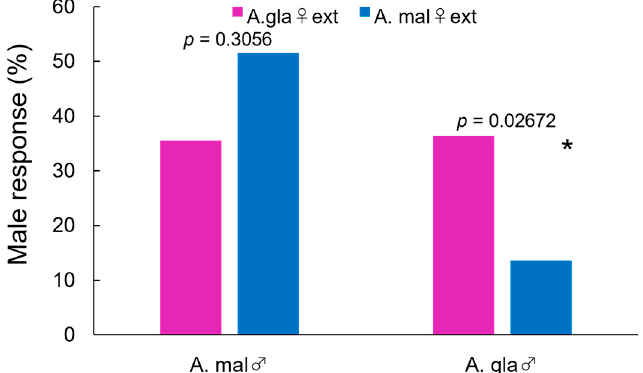
Figure 2. Male abdominal bending response to a glass model that was coated with A. glabripennis or A. malasiaca female extracts (0.5 fe) (Bioassay 1). N = 31 for A. malasiaca males, and N = 44 for A. glabripennis males. * Data were analyzed using Pearson’s Chi-squared test with Yates’